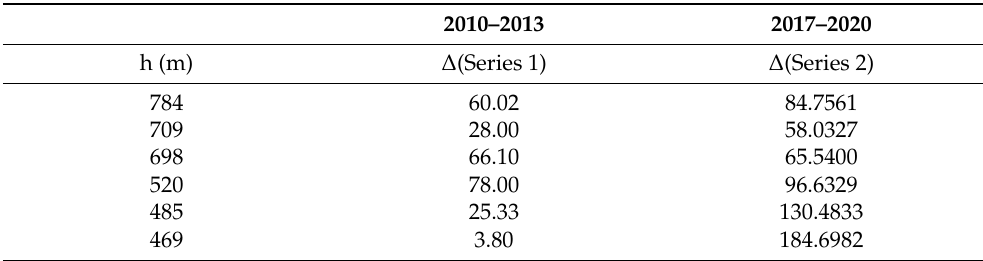
Table 8. Height according to measurement locations and heat difference between pollutants and urban meteorology.